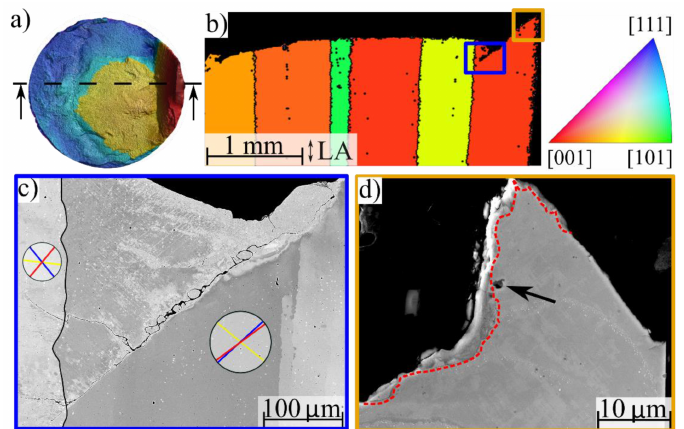
Figure 8. Investigation of the cross section of a sample deformed at σ a = 209 MPa. ( a ) Overview of fracture surface including the cutting plane (black dashed line). ( b ) Overview of the EBSD scan of the cross section with an orientation perpendicular to the load axis in colour code according to IPF. ( c ) BSE image of a cross section including calculated slip traces sorted by the highest Schmid factor (1st red, 2nd blue, 3rd yellow) using a Matlab toolbox for analyzing crystallographic textures (MTEX). ( d ) Detailed SE image of the fracture surface cross section including a dashed line to indicate the thin surface